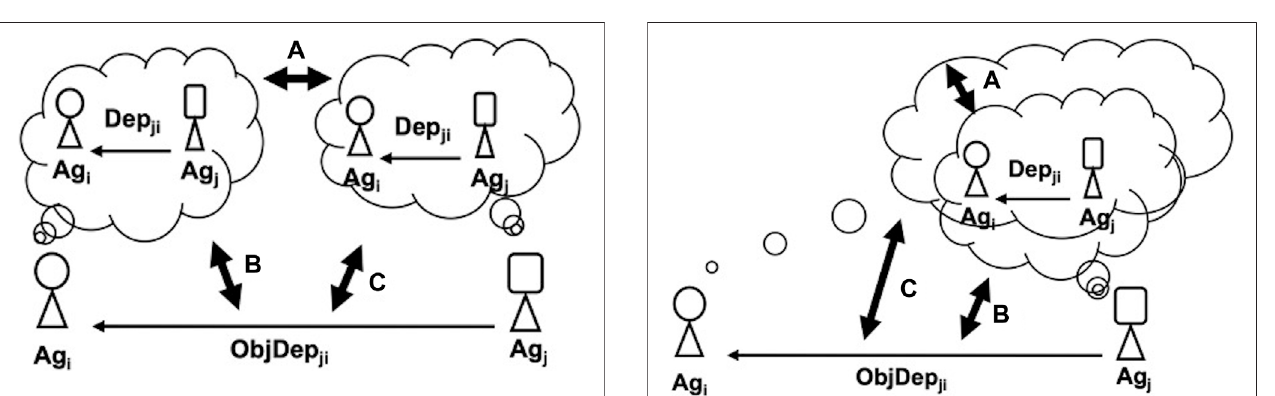
FIGURE 5 | Dependence of Ag j from Ag i on the task τ ’ . (A) comparison on how it is believed by Ag j and how Ag i believes it is believed by Ag j ; (B) comparison on how it is believed by Ag j and objective reality; (C) comparison on how Ag i believes it is believed by Ag j and objective